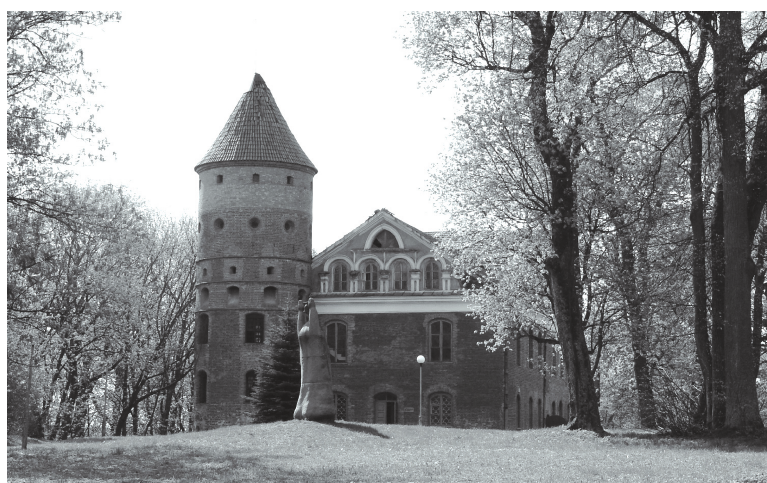
figure 3. The residence of raudondvaris manor: the renaissance style palace surrounded by the landscape style park of the 19th century (photograph by